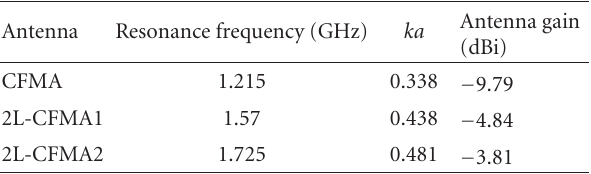
Table 1: The antenna characteristics at the resonance frequency. Table 2: The antenna characteristics at the resonance